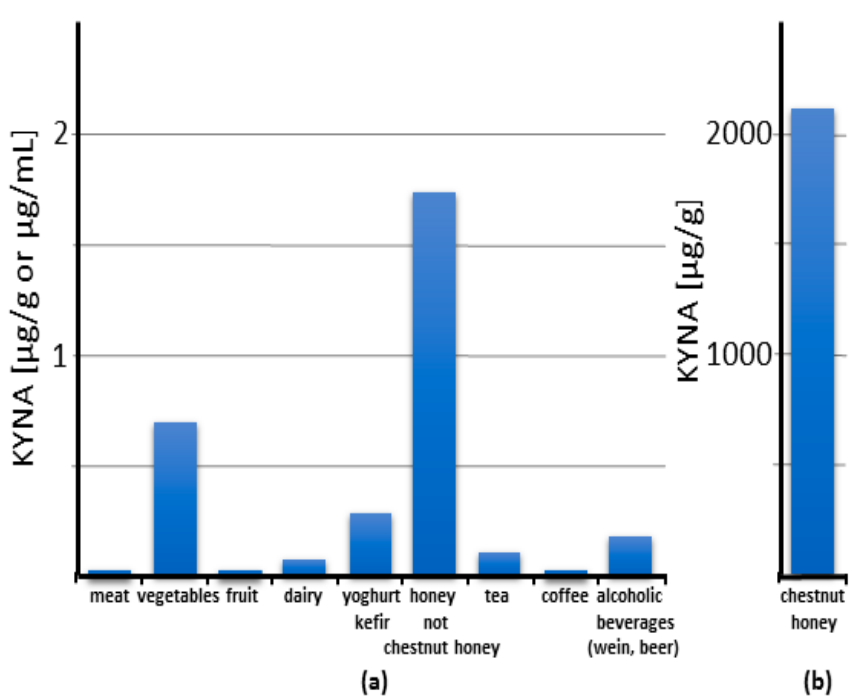
Figure 3. Content of kynurenic acid (KYNA) in food categories: an overview. The columns reflect the value of the highest reported content of KYNA in each category. Note that the scale on panel ( b ) is 1000 times larger than on panel ( a ).